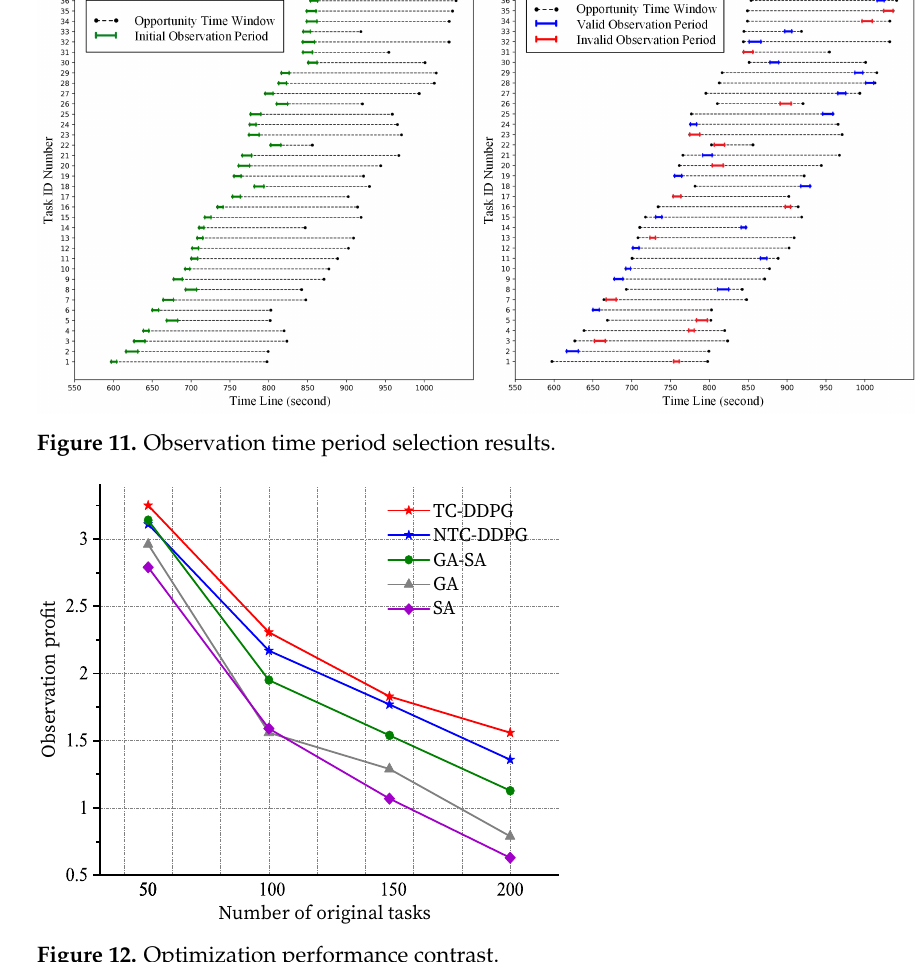
Figure 12. Optimization performance contrast.